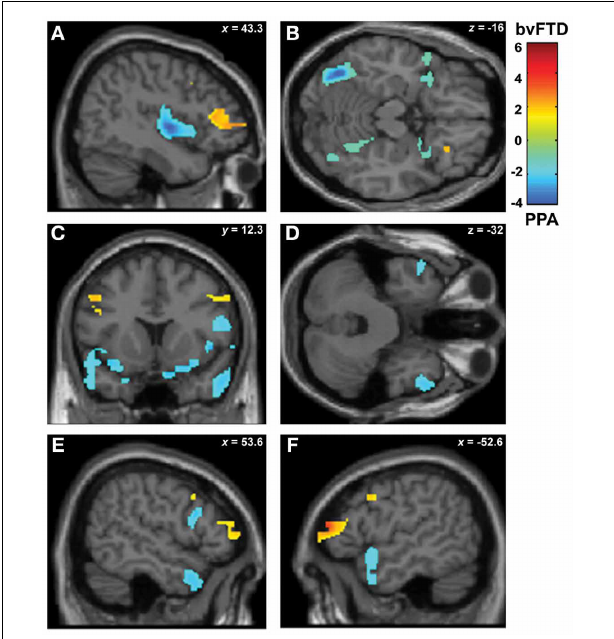
FIGURE 3 | Contrast vectors of bvFTD (red-yellow) and PNFA (light blue) atrophy that correlates with face recognition. p < 0 . 05, small volume corrected. (A) Right insular (PNFA) and IFG (bvFTD) correlations; (B) Bilateral posterior fusiform and temporal pole correlations for PNFA; (C) Bilateral insular and temporal pole (PNFA) and mid frontal gyrus (bvFTD) correlations; (D) Bilateral temporal pole in PNFA; (E) and (F) . Most lateral right (E) and left (F) frontal and temporal pole associations for PNFA and bvFTD. PNFA, progressive non-fluent aphasia, bvFTD, behavioral variant FTD; IFG, inferior frontal